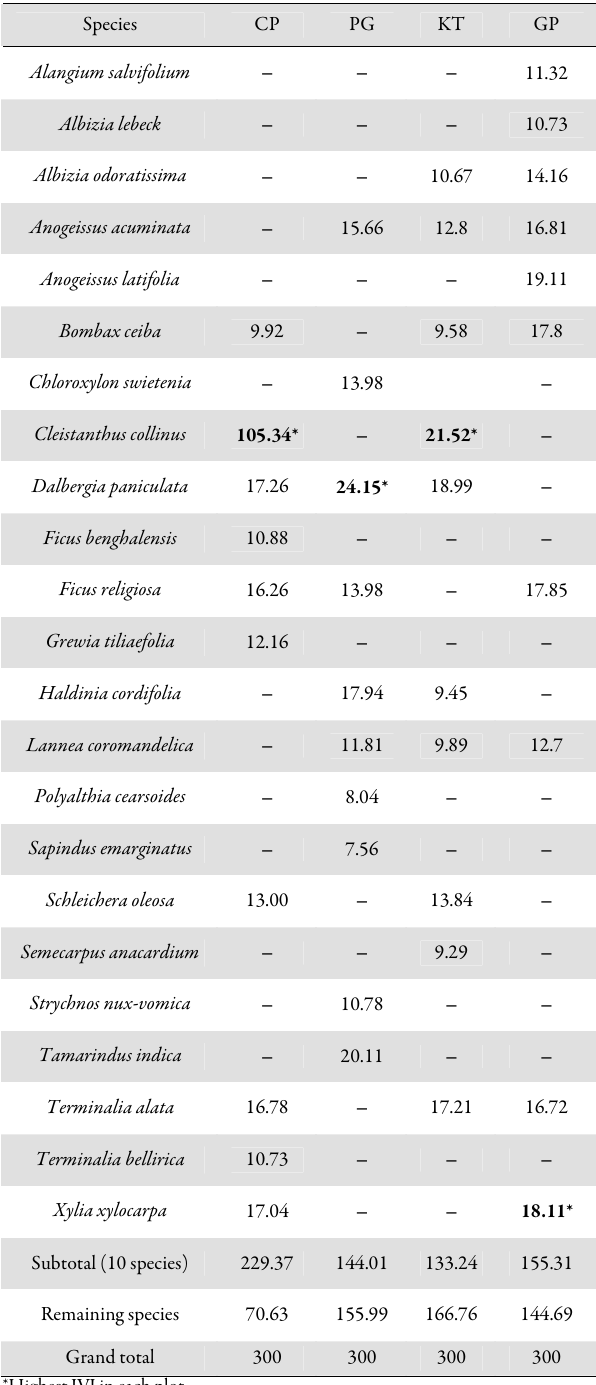
Tab. 4. Top ten IVI of the tree species in four 1-ha plots